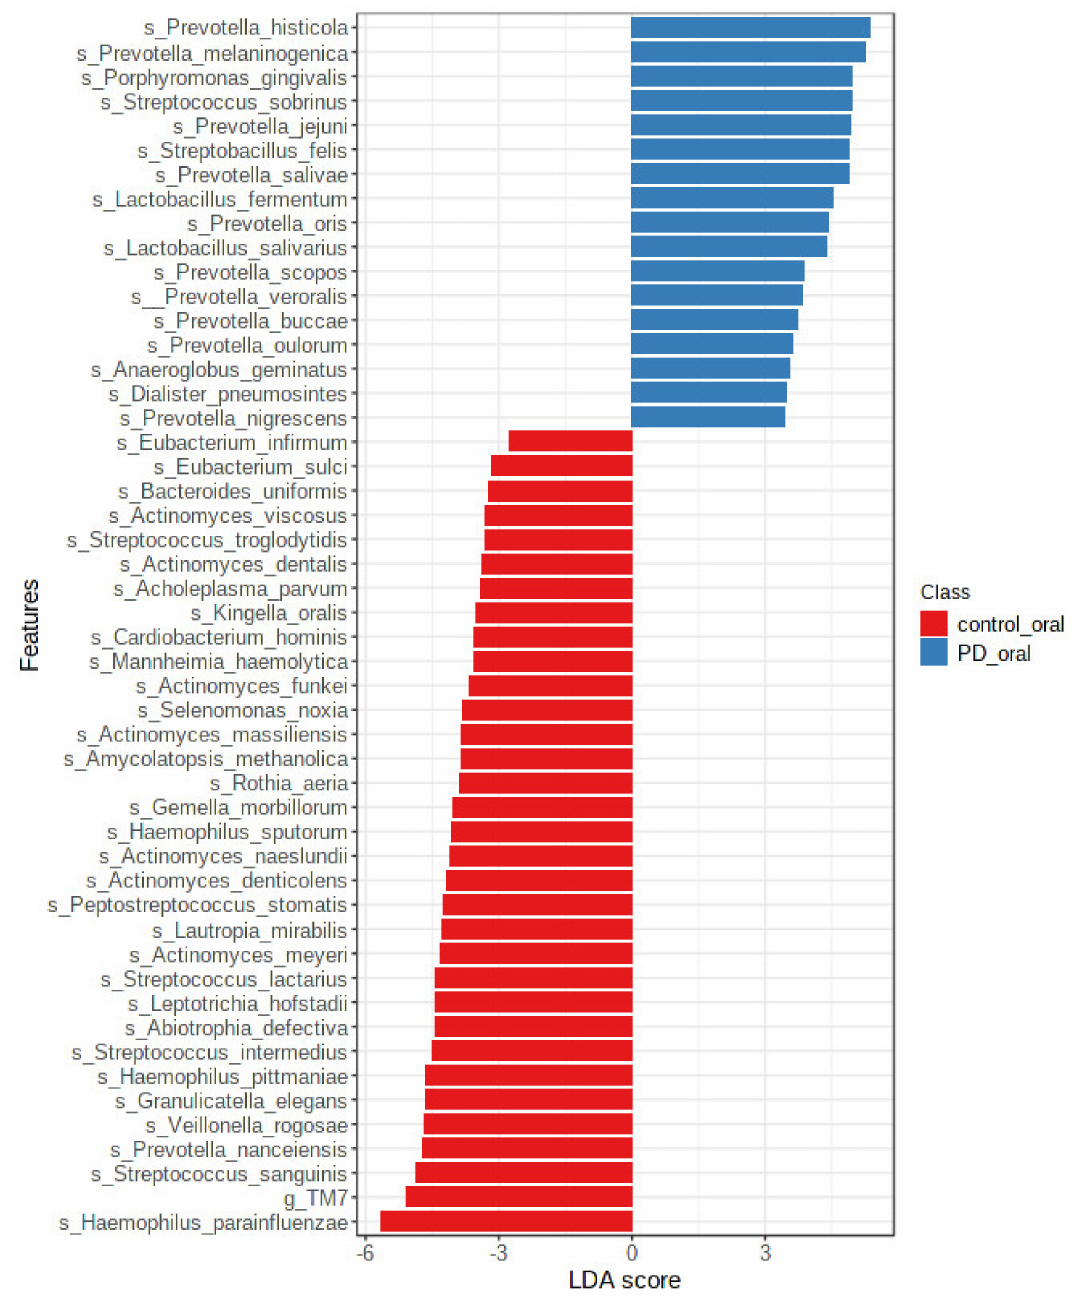
Figure 6. There are differences in oral microbiota between patients with PD and the healthy controls at the genre